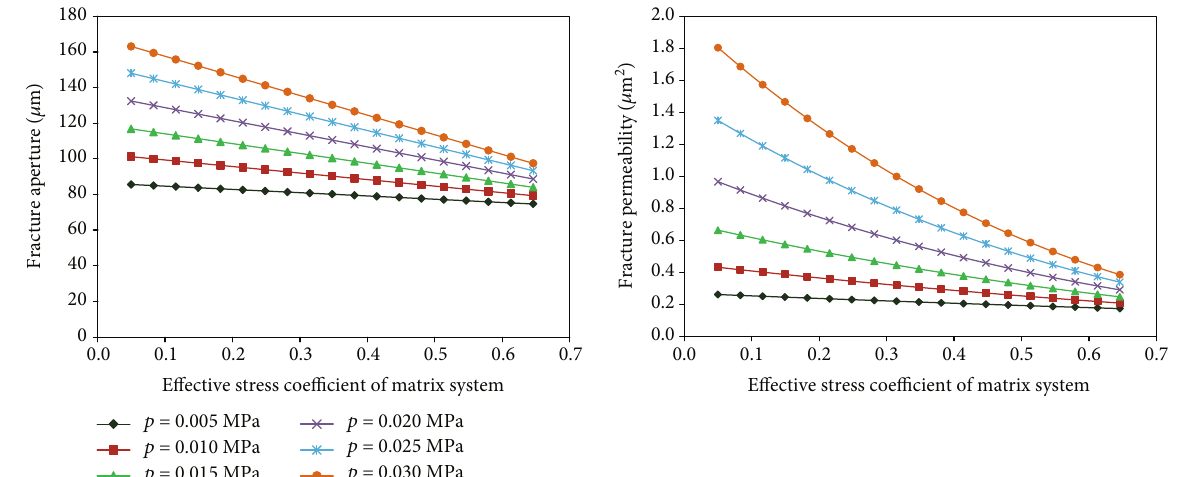
Figure 16: Fracture aperture and fracture permeability vs. e ff ective-stress coe ffi